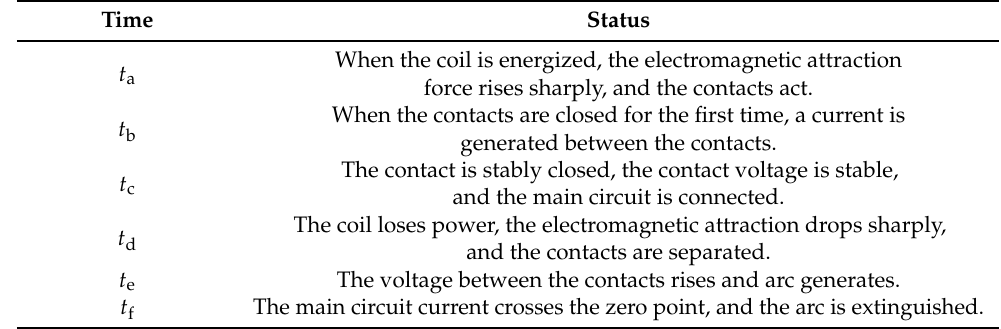
Table 3. Status of